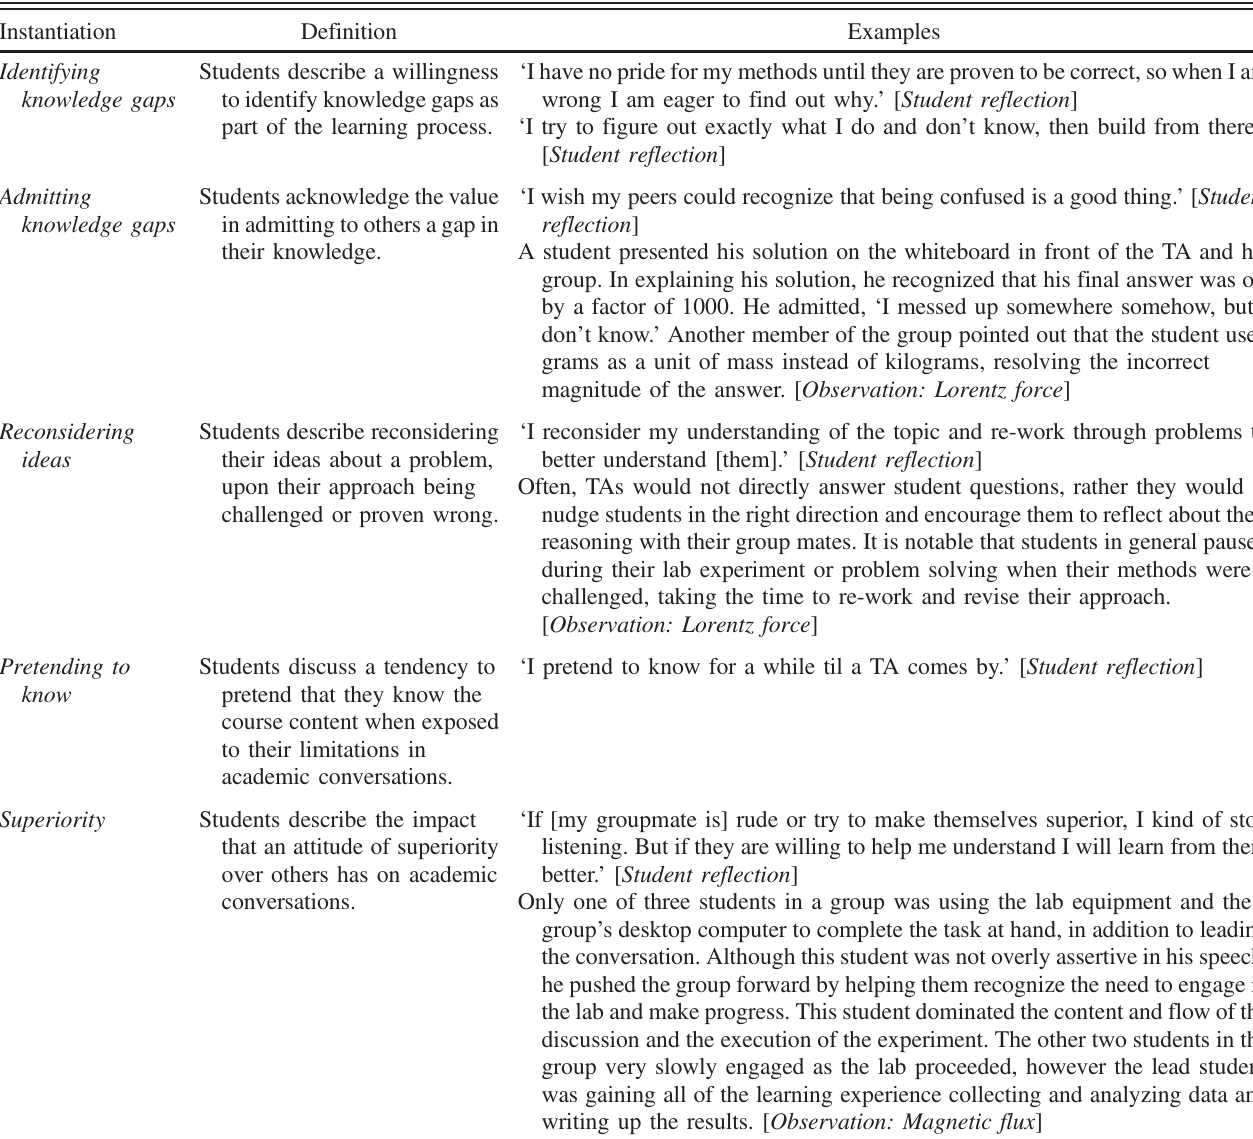
TABLE III. Definitions and examples of instantiations related to owning intellectual